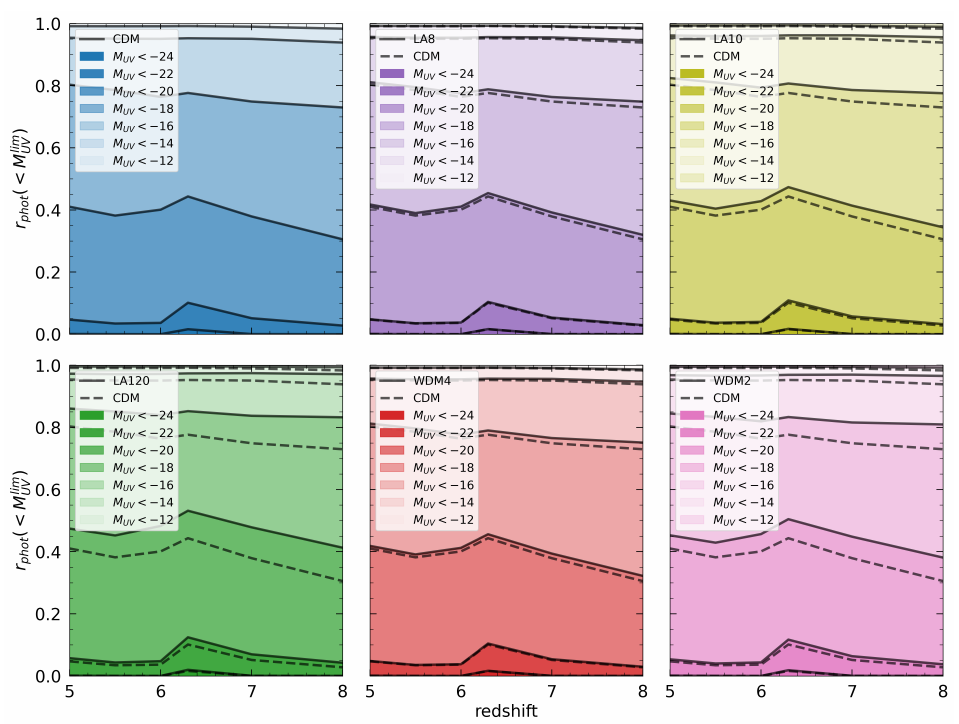
Figure 3. The multiple panels show the integrated photons ratio r phot ( < M UV computed by integrating Equation (5) between intrinsic M sup with CDM two thermal WDM cosmologies (WDM3 is an intermediate case between WDM4 and WDM2), and three sterile neutrino cosmologies (here LA10 is the only representative scenario for radiatively decay Dark Matter, which is compatible with the 3.5 keV emission line observed in galaxy